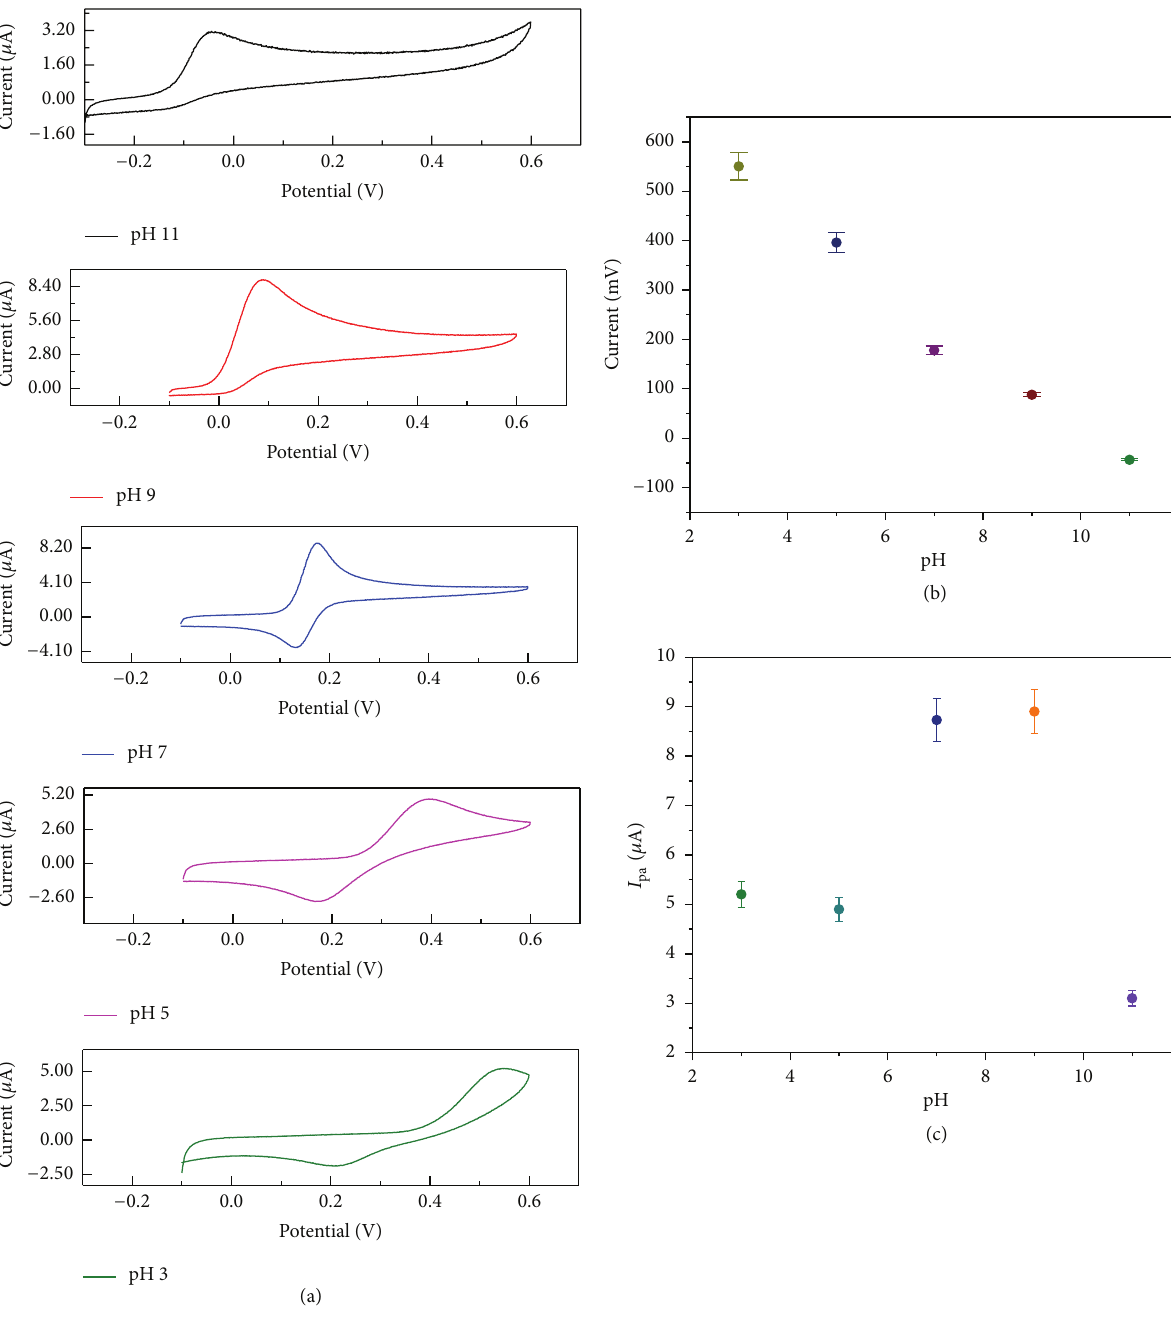
) and (c) anodic peak current (𝐼 pa